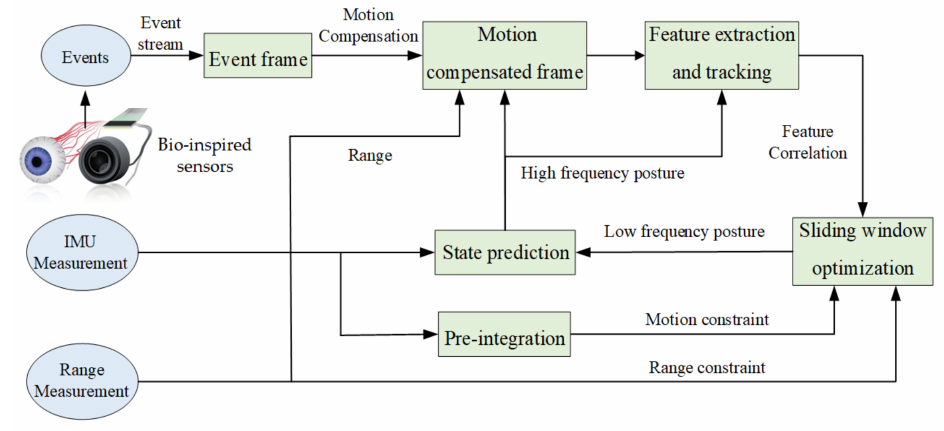
Figure 1. Overview of the proposed